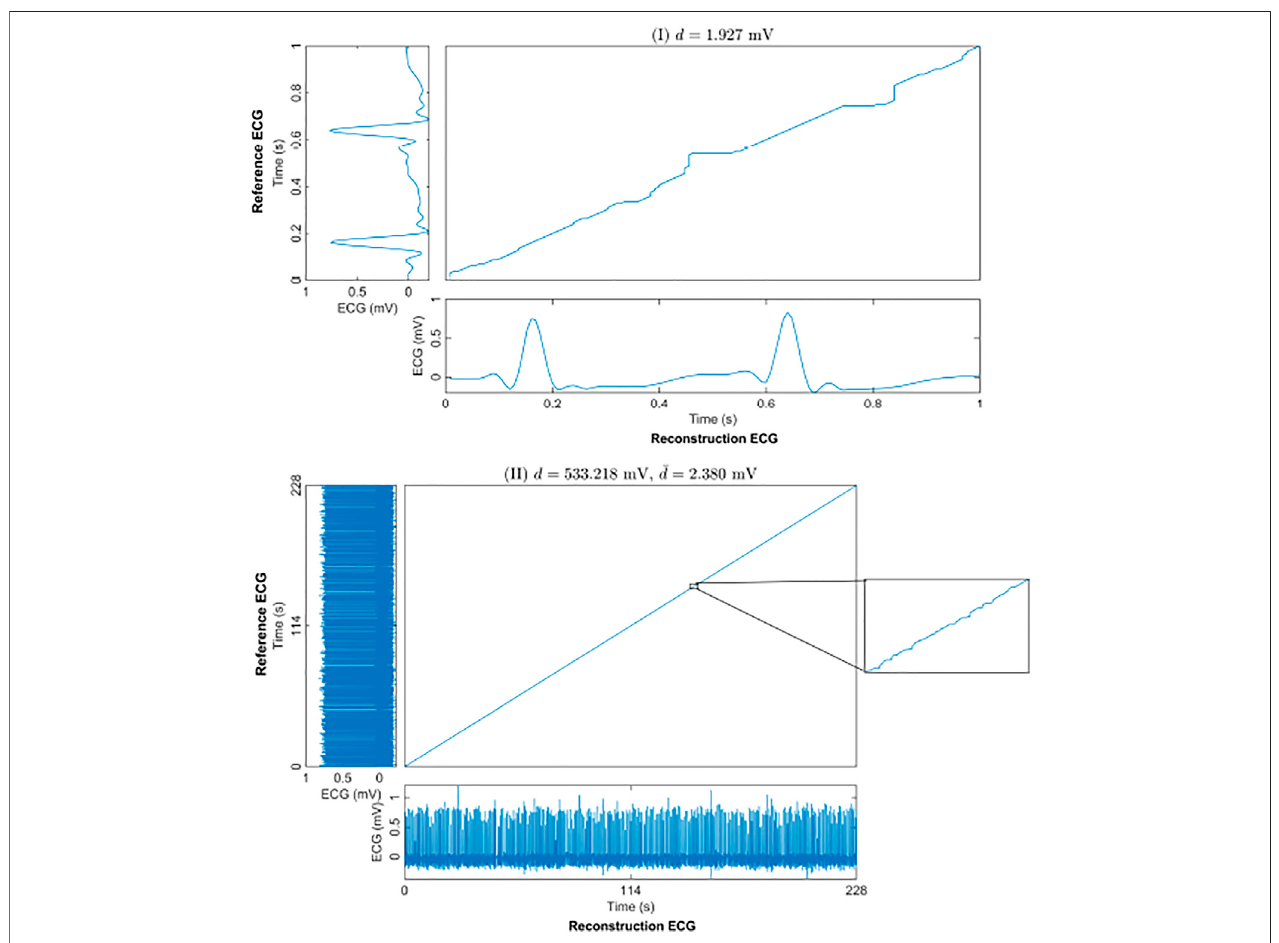
FIGURE 5 | The optimal warping path of the reconstruction and reference ECGs using DTW. (I) shows an example of a 1-s segment. (II) shows the result of the whole 228-s test set for one subject. d is the DTW distance of the 228-s reconstruction and reference ECGs. And (cid:1) d is d divided by the signal time length of 228 s.